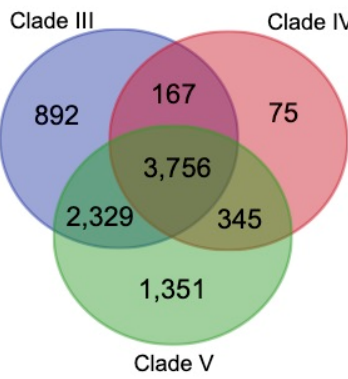
Figure 3. Gene family numbers of three nematode clades. The number of gene families for Clade IV shared 3923 with Clade III and 4101 with Clade V. The three clades shared 3756 gene